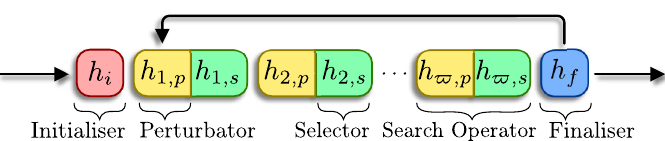
Figure 1. Block-diagram of a metaheuristic composed by an initialiser h i , (cid:118) perturbators h j , p and selectors h j , s , ∀ j ∈ { 1, . . . , (cid:118) } , and a finaliser h f .